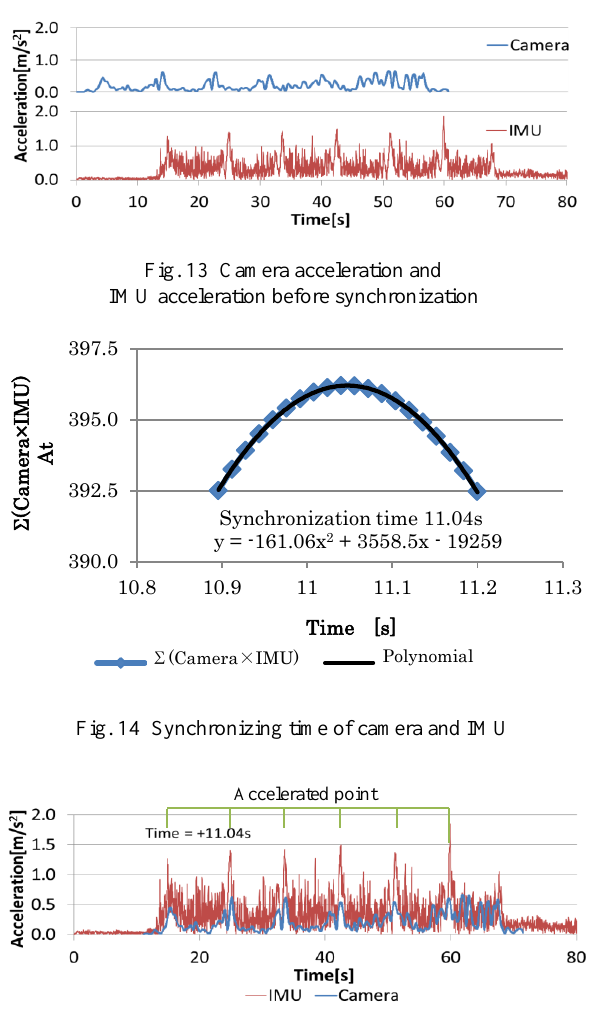
Fig. 15 Camera acceleration and IMU acceleration after synchronization